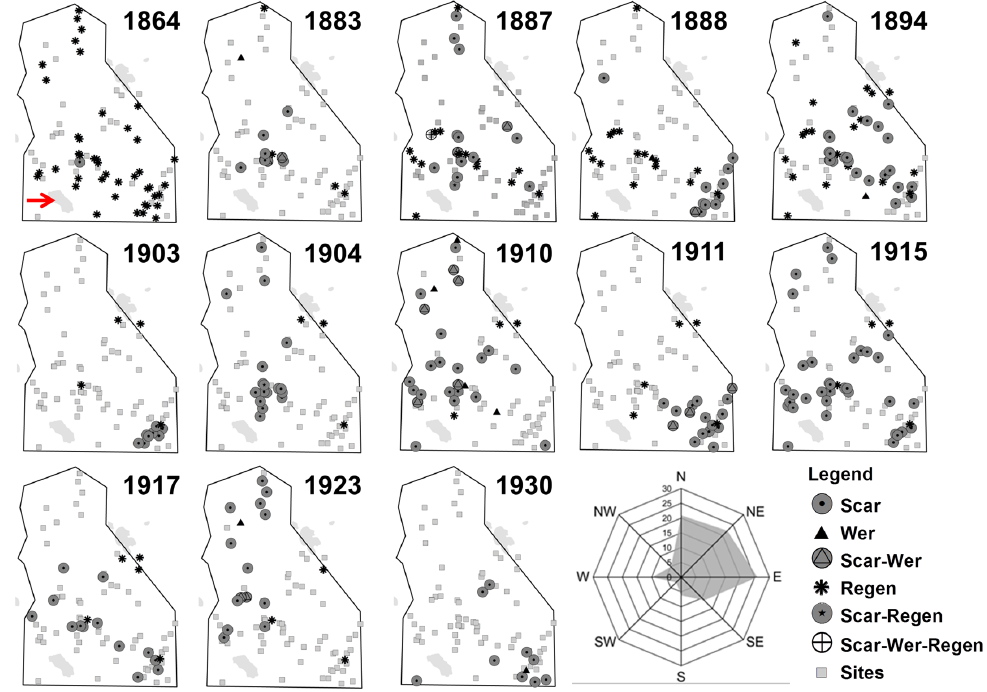
Figure 8. Spatial distribution of sampling sites and fire ‐ scarred Pinus banksiana trees for 13 major fire years in the LKFMU. Fire scars, white earlywood rings (WER), and regeneration as well as combinations of them are indicated in the legend. A wind rose depicting the frequency of fire spread directions is also presented. The arrow indicates the location of Lake Katherine.